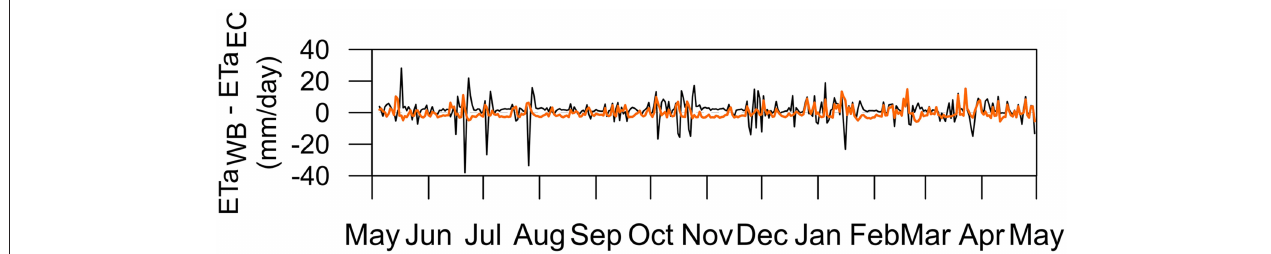
FIGURE 8 | Differences between the mean water balance estimates (without the change in storage term) with EC measurements (orange line) and the differences between the mean water balance estimates (including the change in storage term) and the EC measurements (black